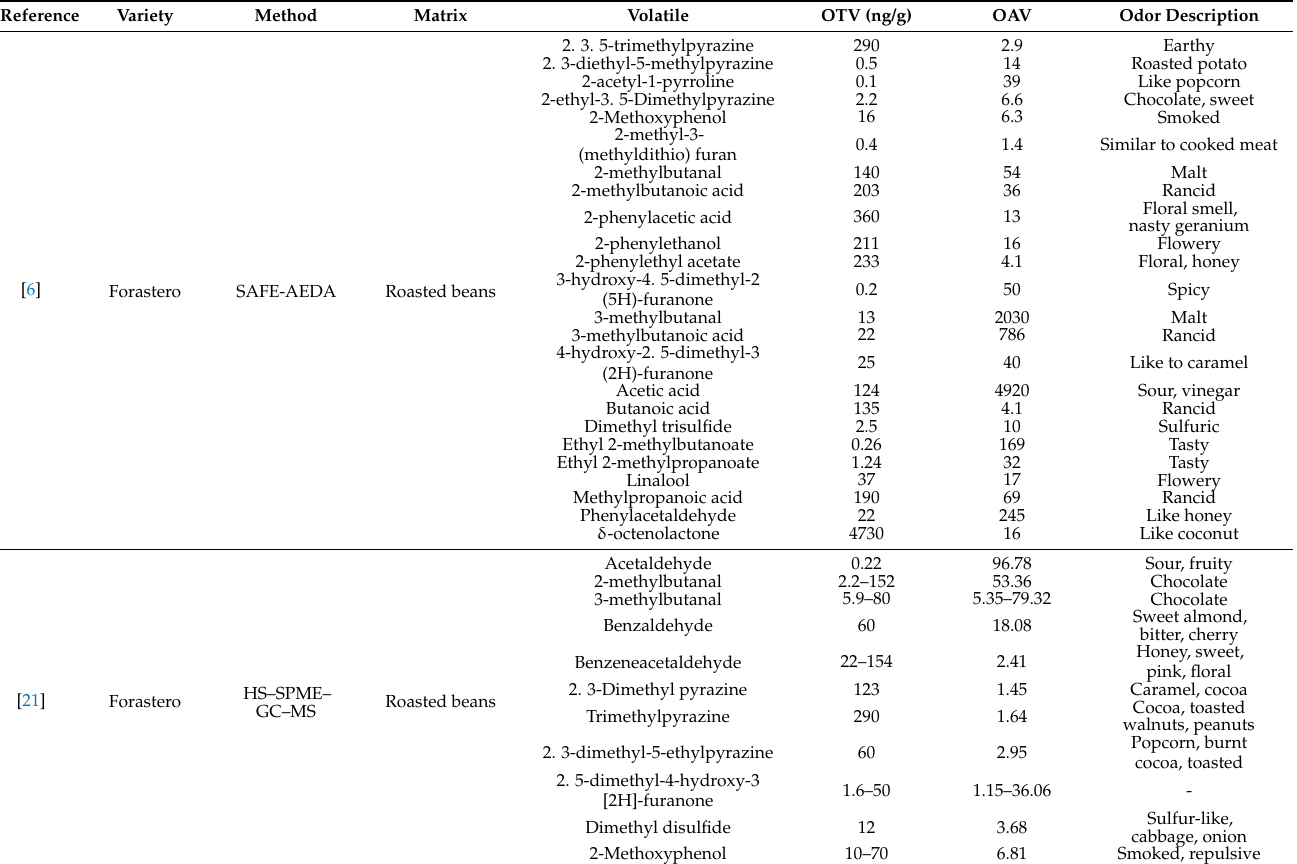
Table 4. Odor activity values of key aroma compounds in roasted